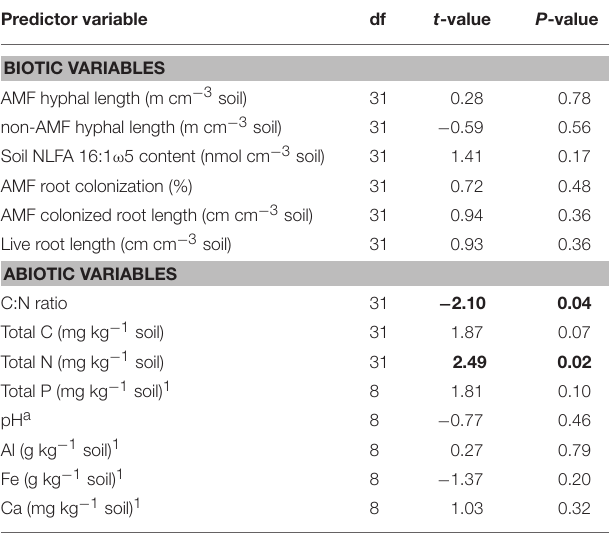
TABLE 1 | Responses of soil aggregation as well as biotic and abiotic soil factors to N and P additions, as well as the interaction between N and P additions (N:P) (two-way linear mixed-effects models, F -values ( P- values) are presented).